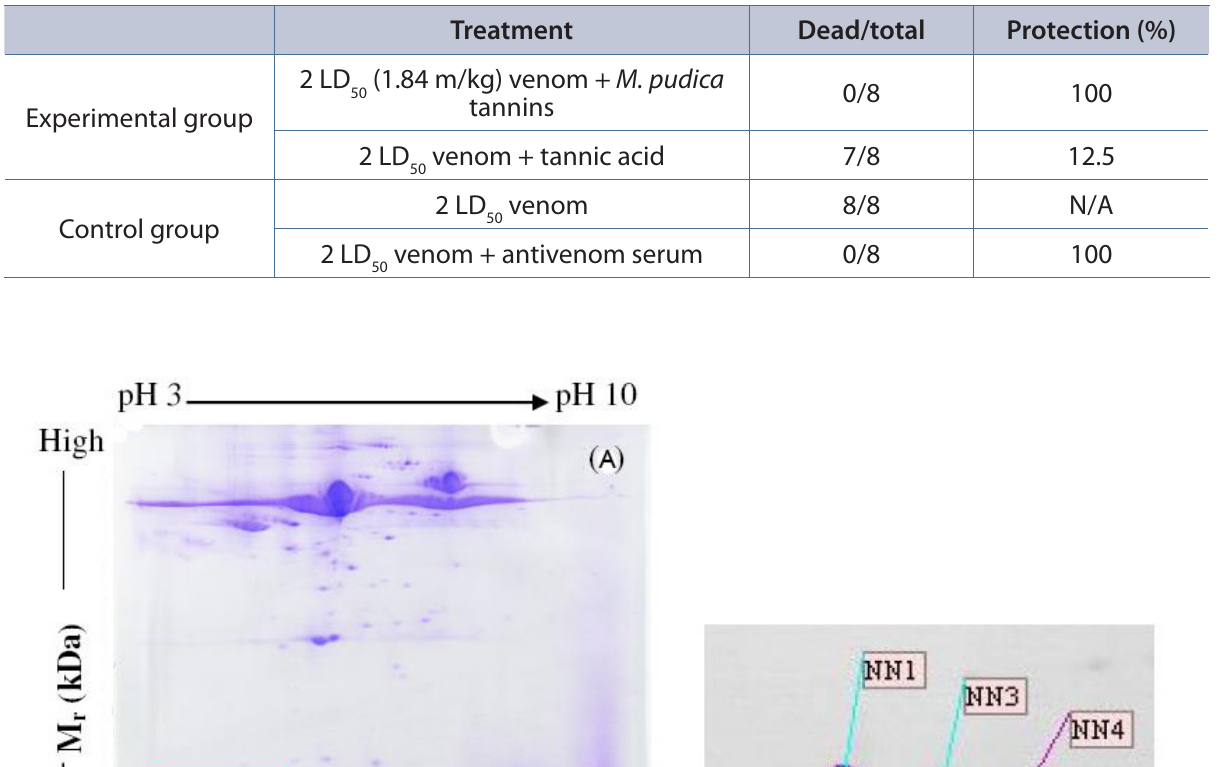
Table 3. Results of the in vitro experiment